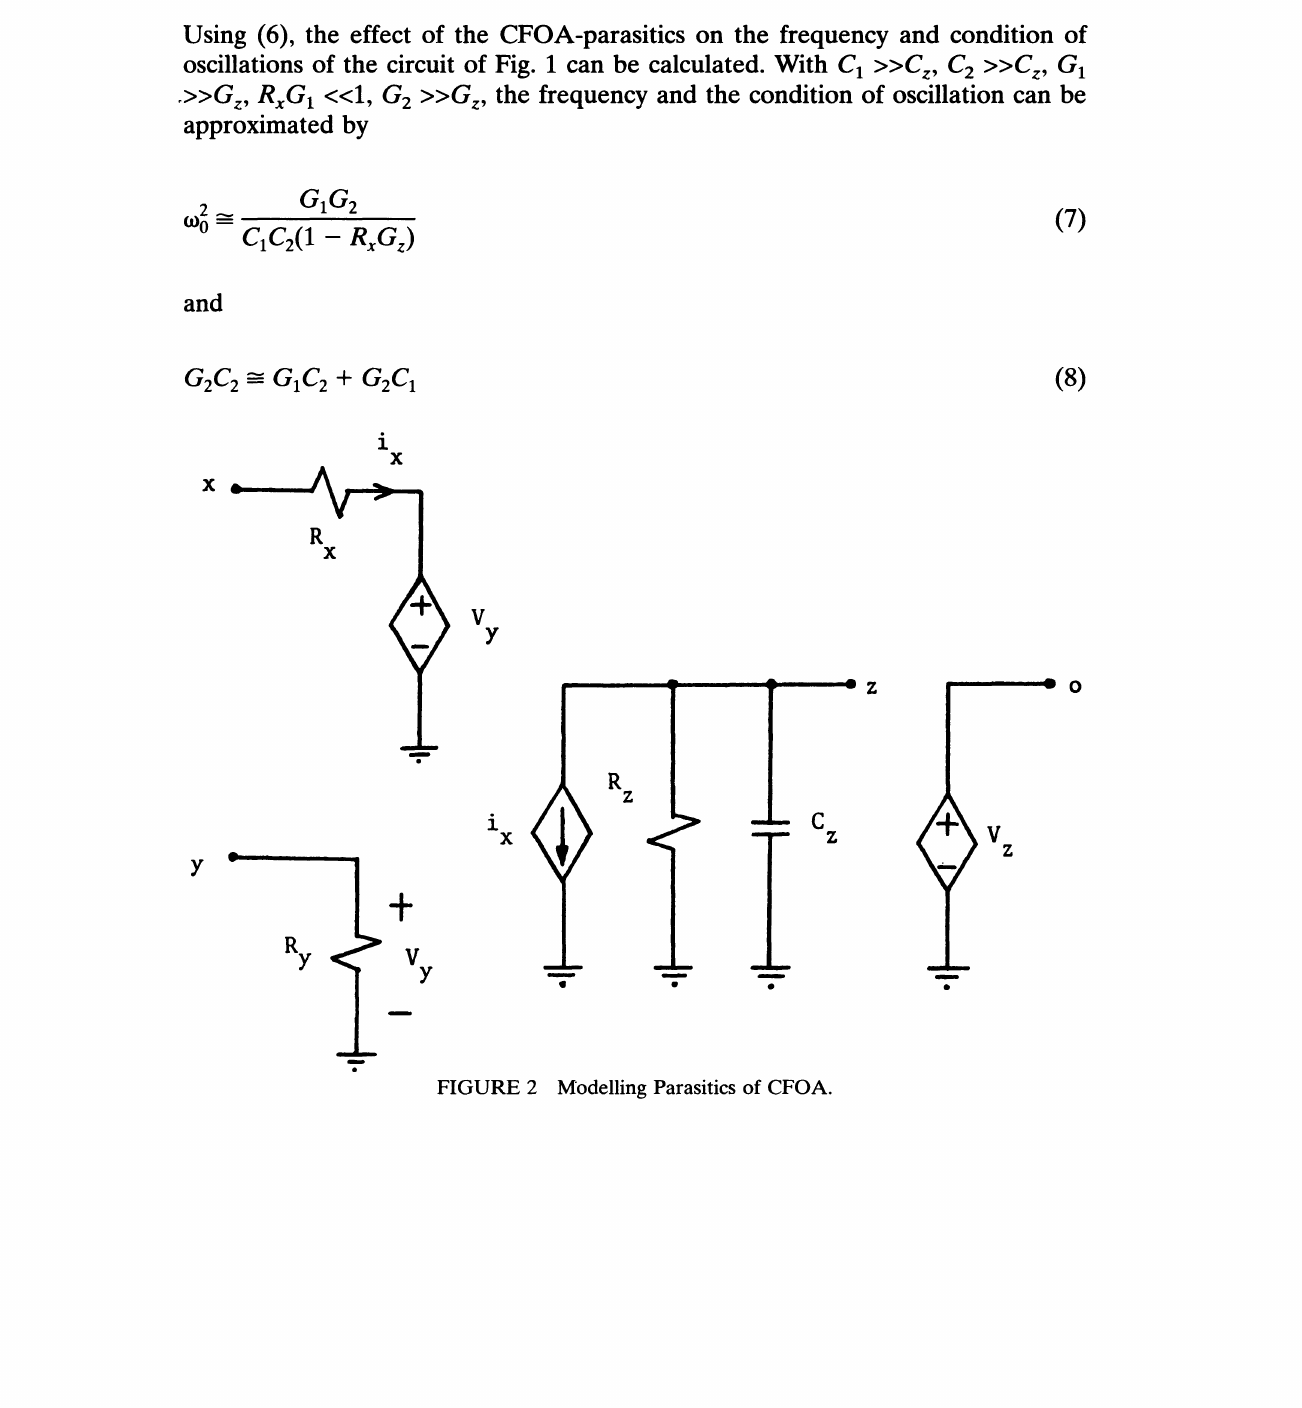
FIGURE 2 Modelling Parasitics of